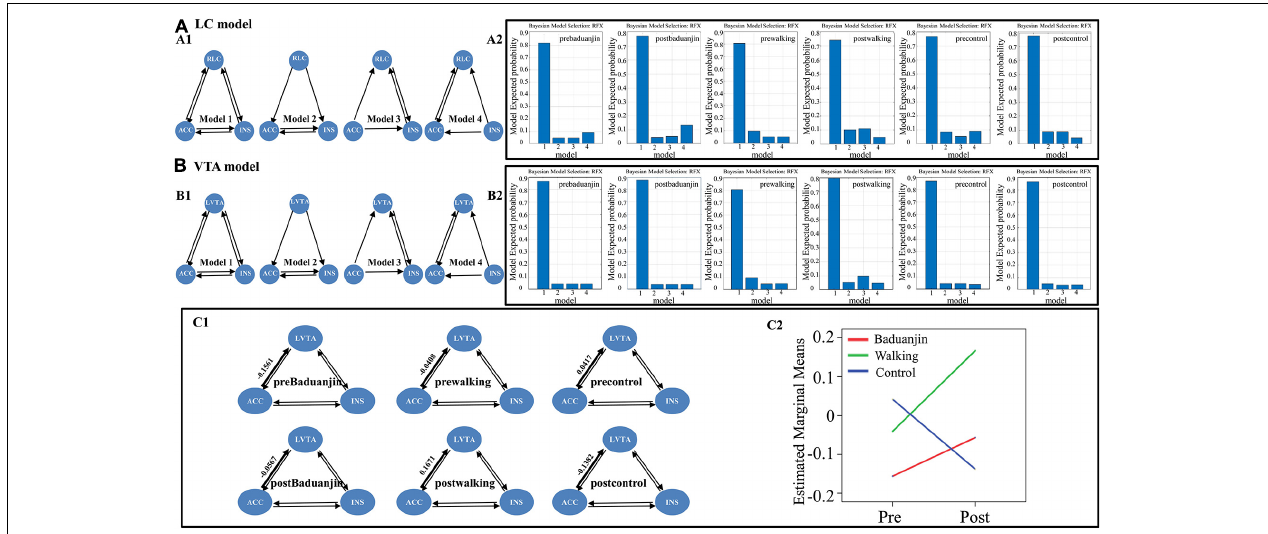
FIGURE 3 | The “right LC model” and “left VTA model” setup, the winning sub-model at the condition level in the “right LC model” and “left VTA model,” and the group and time interaction of right ACC to left VTA effective connectivity. (A) The “right LC model” and the winning sub-model at the condition level in the “right LC model”. (A1) right LC model setup: model 1-4, sub-model of the “right LC model,” model 1-full connective model, model 2- right LC predominantly affected the others, model 3- right ACC predominantly affected the others, model 4-right insula predominantly affected the others; (A2) the winning sub-model of the “right LC model” in each condition (i.e., pre-Baduanjin, post-Baduanjin, pre-walking, post-walking, pre-control, post-control); (B) The “left VTA model” and the winning sub-model at the condition level in the “left VTA model”. (B1) Left VTA model setup: model 1-4, sub-model of “left VTA model,” model 1-full connective model, model 2-left VTA predominantly affected the others, model 3-rigth ACC predominantly affected the others, model 4-right insula predominantly affected the others; (B2) the winning sub-model of the “left VTA model” in each condition (i.e., pre-Baduanjin, post-Baduanjin, pre-walking, post-walking, pre-control, post-control). (C) Mean connection strengths and the group and time interaction of right ACC to left VTA effective connectivity. (C1) Mean connection strengths for the effective connectivity of right ACC to left VTA. (C2) The group and time interaction for the effective connectivity of right ACC to left VTA. RLC: right locus coeruleus; LVTA: left ventral tegmental area; ACC: right overlapped anterior cingulate cortex; INS: right overlapped insula.